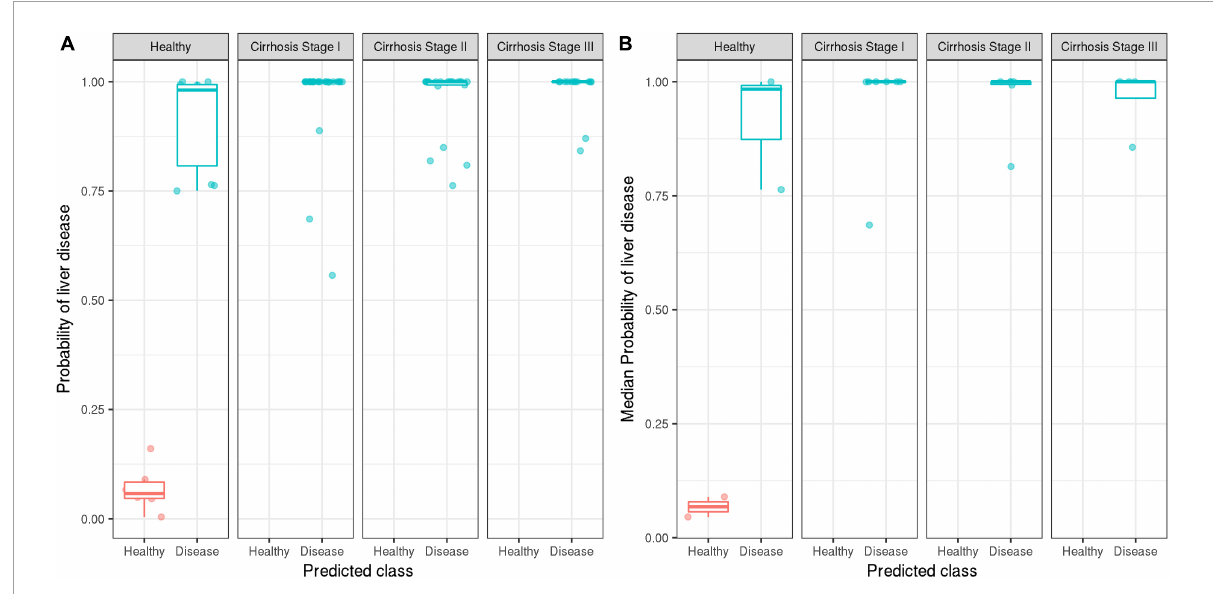
FIGURE5 Distribution of the ensemble model’s predicted probabilities for healthy vs. disease classifications stratified by the true stage of cirrhosis. Ground truth labels of healthy (red) and disease (blue) are displayed. On the y -axis, probability values of model output are displayed. Model performance is reported at the sample level (A) , as well as patient level (B) by aggregating based on median